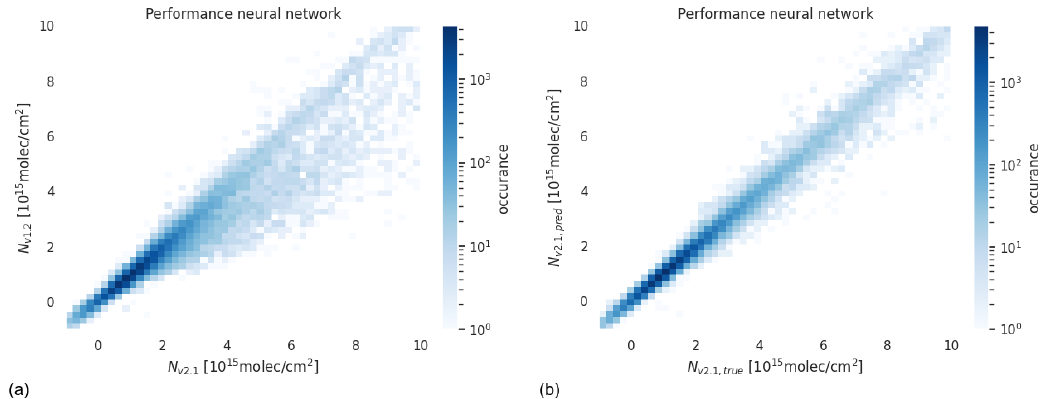
Figure E1. (a) Scatterplot of TROPOMI v1.2 (uncorrected) vs. actually retrieved v2.1 TROPOMI NO2 columns observed over Europe in the four test periods. (b) Scatterplot of DNN-predicted vs. actually retrieved v2.1 TROPOMI NO 2 columns observed over Europe in all areas and periods under